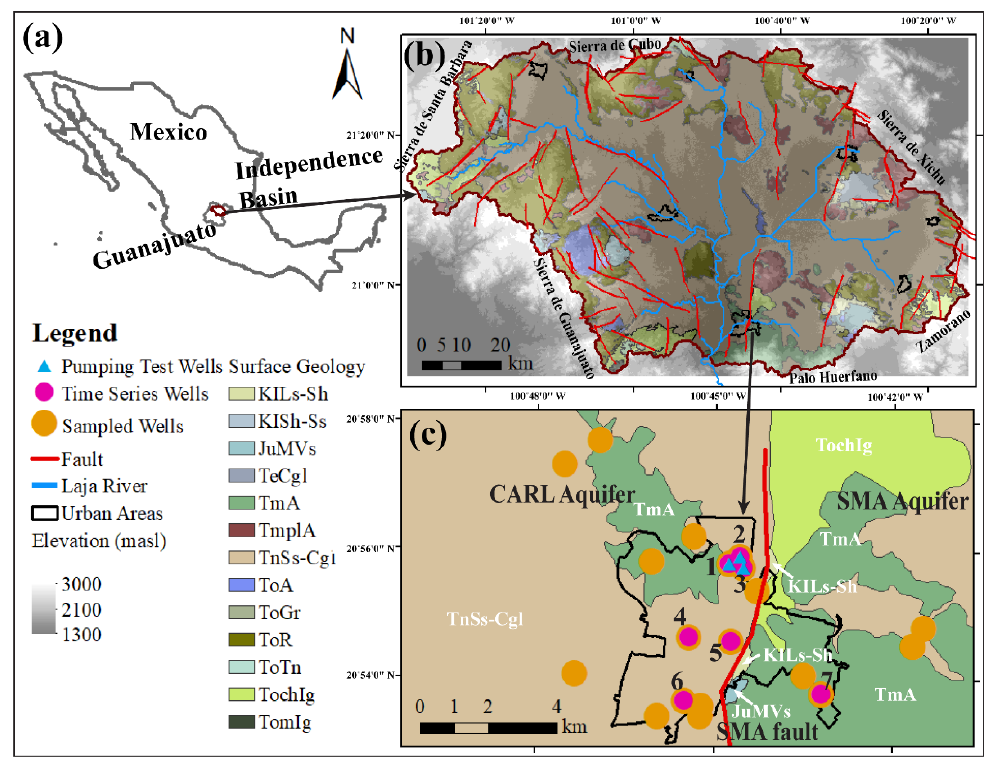
Figure 1. ( a ) Location of Guanajuato State and the Independence Basin. ( b ) The distribution of surficial rock or sediment type and deposition age, topography and the locations of major faults and urban areas within the basin. masl is meter above sea level. ( c ) Surface geology and location of pro ‐ duction wells (large orange circles) within the SMA urban area. Seven pink circles indicate wells monitored continuously during a one ‐ day pumping. Three blue triangles indicate wells used for the pumping test. The SMA fault cuts through the city trending in the NNE ‐ SSW direction (solid red line). The surface geology symbols mean: KILs ‐ Sh: Lower Cretaceous Metamorphic Limestone; KISh ‐ Ss: Lower Cretaceous Metamorphic shale interbedded with metamorphic sandstone; JuMVs: Lower Cretaceous Meta ‐ volcanosedimentary; TeCgl: Tertiary Eocene polymictic conglomerate; TmA: Tertiary Miocene Andesite; TmplA: Tertiary Miocene–Pliocene Andesite; TnSs ‐ Cgl: Tertiary Neogene interbedded Sandstone and polymictic Conglomerate; ToA: Tertiary Oligocene Andesite; ToGr: Tertiary Oligocene Granodiorite; ToR: Tertiary Oligocene Rhyolite; ToTn: Tertiary Oligocene Tonalite; TochIg: Tertiary Oligocene Chattian Ignimbrite; TomIg: Tertiary Oligocene–Miocene Ig ‐ nimbrite. Detailed geologic borehole lithologies were, unfortunately, not available for any of the 19 municipal wells that supply water to SMA, and therefore, the geologic layering could not be precisely determined in the study area. Visual inspection of well log videos obtained from SAPASMA, however, provided a clue for inferring the depth within the aquifer where important changes in Eh or pH occurred, through characterizing the pres ‐ ence and color of chemical precipitations of hydrous ferric oxides and mechanically accu ‐ mulated particles [67–70]. For example, Figure 2 exhibits the transition from clean to clogged perforations in Wells 1 and 2 which were installed within the low ‐ lying sedimen ‐ tary CARL aquifer in the northern part of the city close to the SMA fault (Figure 1c). For both wells, which are located only 380 m apart and are screened across similar elevations within the aquifer (Table 1), the geochemical transition zone occurs at approximately 1735 m above sea level (masl). This transition was about 80 m below the static water table at the time of the recording of the well log video in 2010. This suggests the presence of two chemically distinct layers within the aquifer across the saturated thickness of the CARL aquifer. Unfortunately, such a clear transition from clean to clogged well perforations was not observable in other wells (Figure S2).